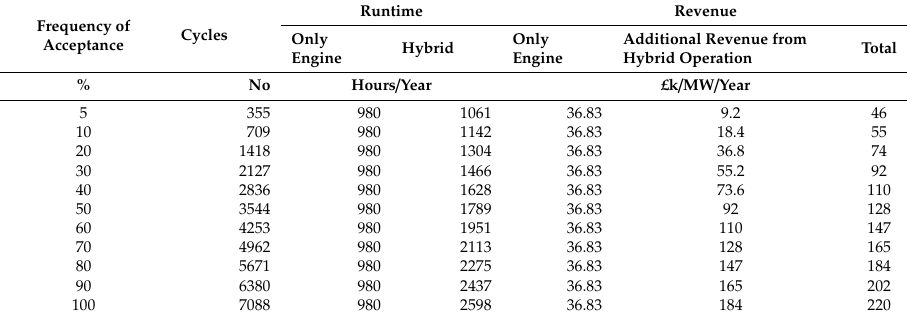
Table 5. Potential BM